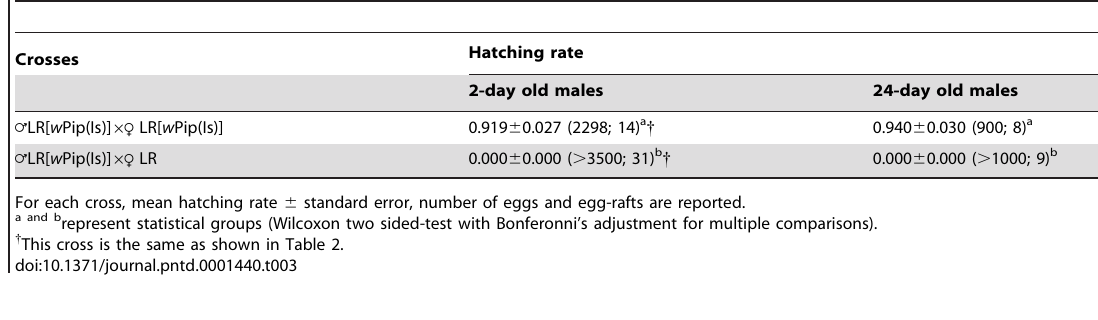
Table 3. Effect of LR[ w Pip(Is)] males ageing on CI phenotype.